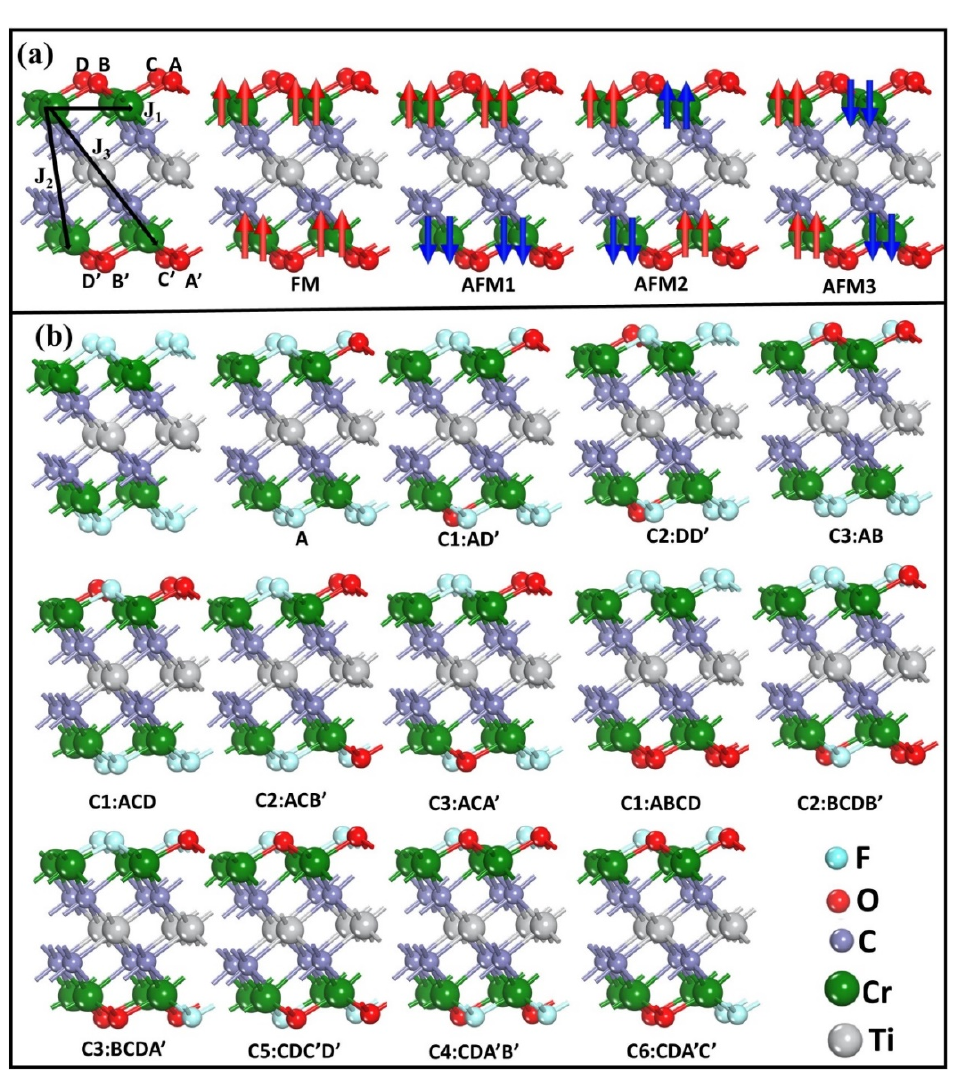
Figure 1. Side views of ( a ) the magnetic arrangements and adsorption sites, and ( b ) configurations of Cr 2 TiC 2 O n/4 F 2 − n/4 ( n = 0, 1, 2, 3, 4). Cr 2 TiC 2 O n/4 F 2 − n/4 ( n = 0, 1, 2, 3,